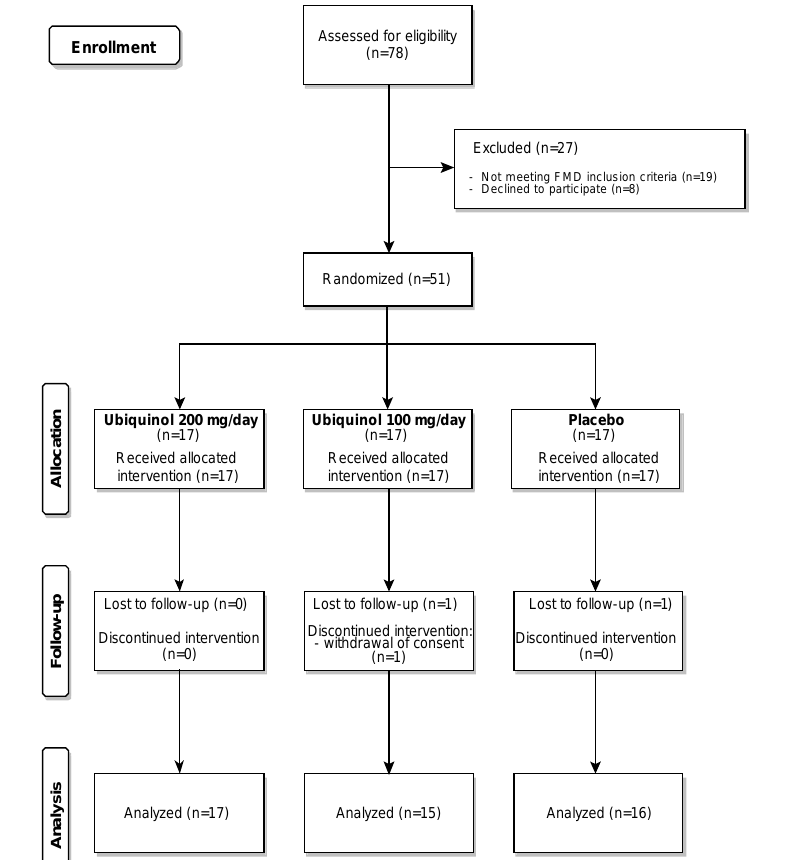
Figure 1. Consolidated Standards of Reporting Trials (CONSORT) flowchart. A total number of 78 patients were screened. Of these, 51 were randomized to the three groups and 48 completed the study. FMD, flow-mediated dilation.